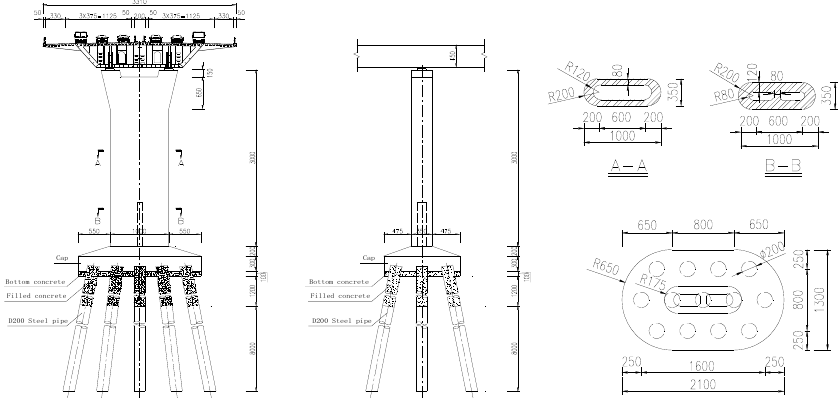
Figure 5. Layout diagram of pier and foundation of the bridge in this study (unit: cm).